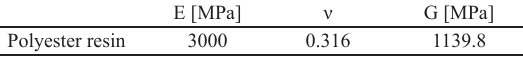
Table 1. Matrix material mechanical properties.